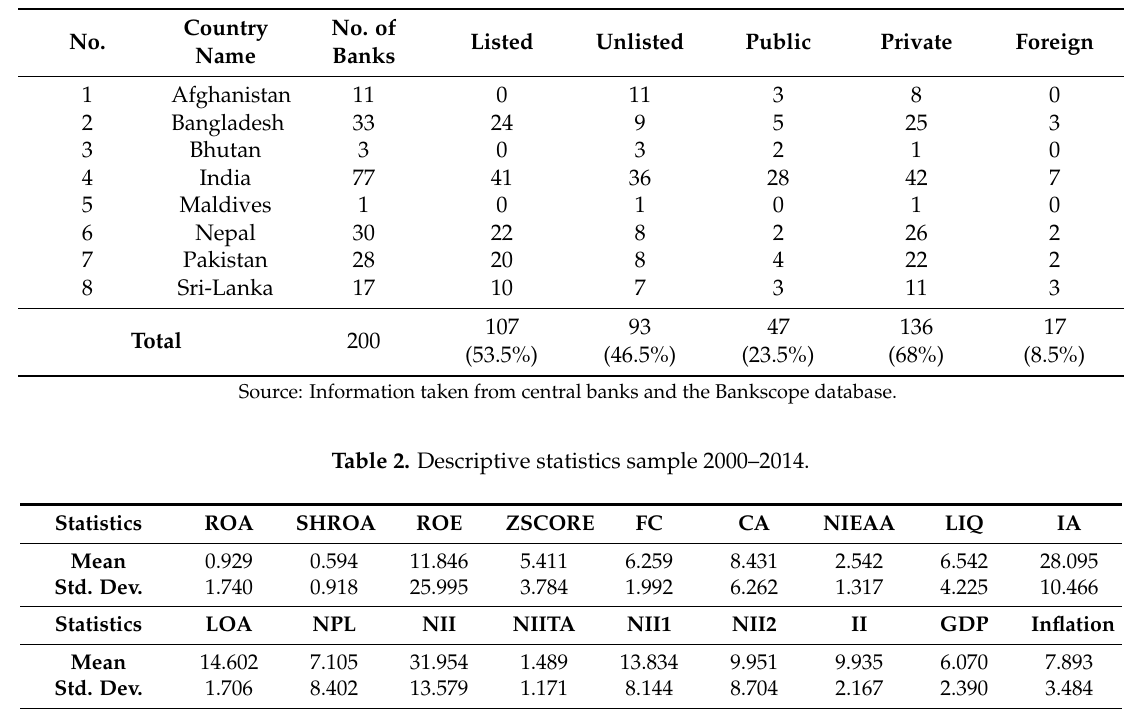
Table 1. Sample summary.